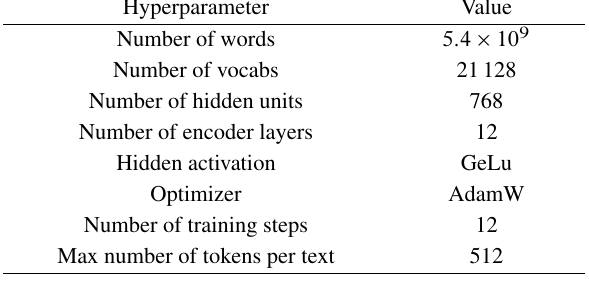
Table 3 The hyperparameters of RoBERTa.